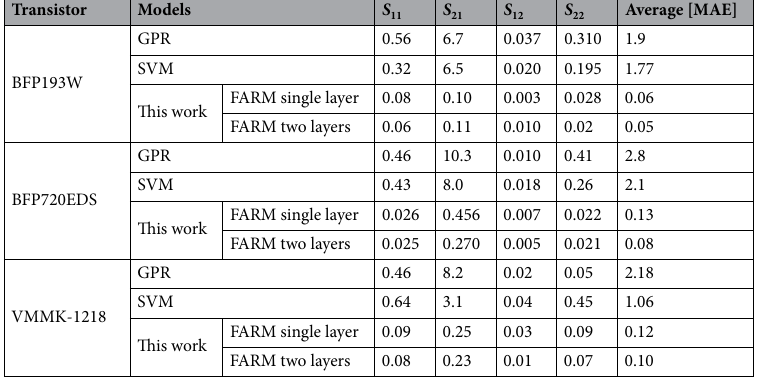
Table 3. Modeling results and